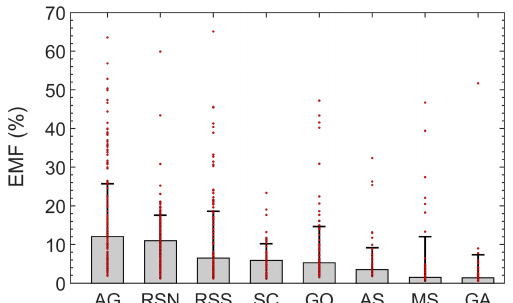
Figure 10. Spatial excess NMHC mole fractions. Bars represent the regional median and error bars the standard deviation. Individual samples are shown with red